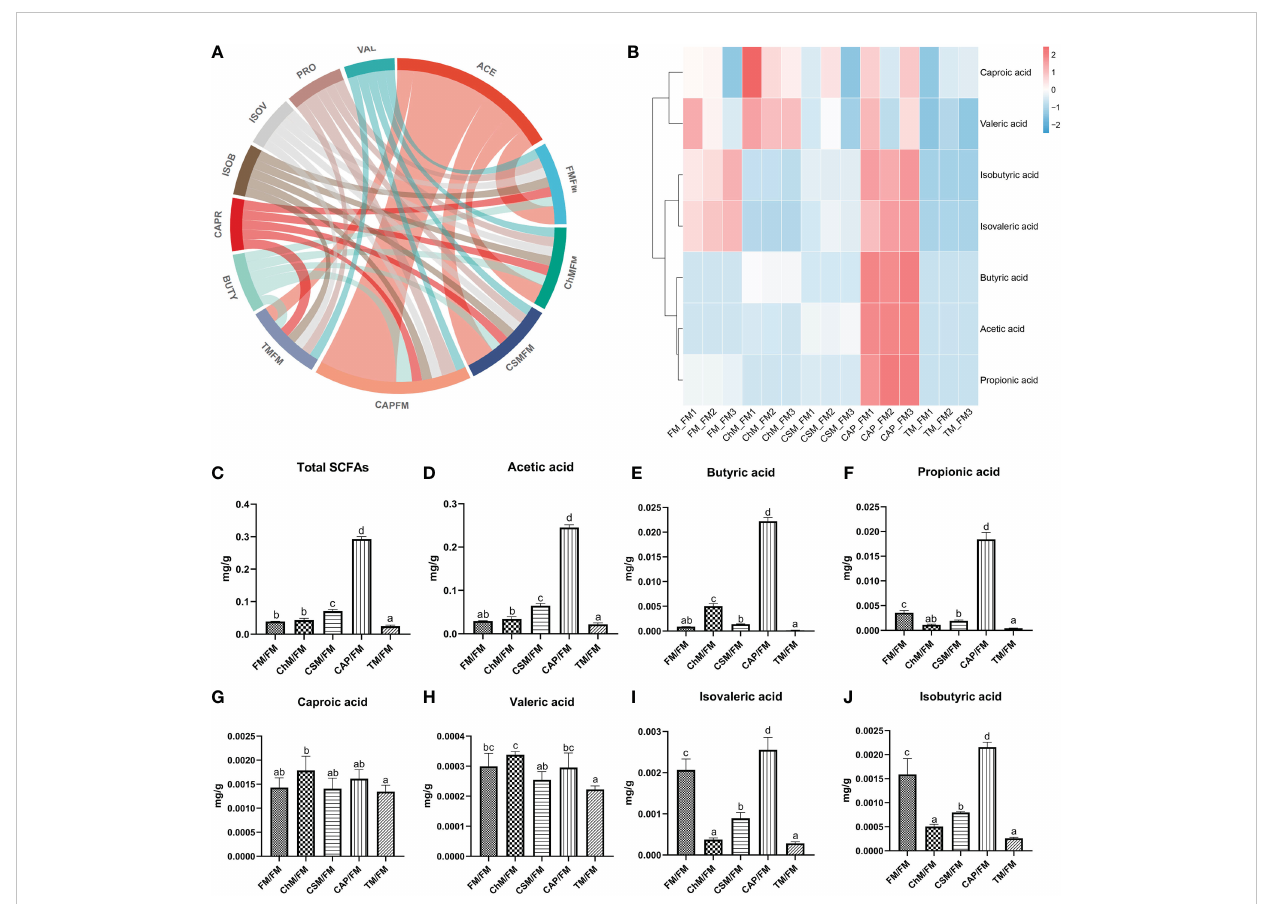
FIGURE 7 The intestinal metabolome of juvenile largemouth bass intestinal contents under an alternate feeding strategy were shown as follows: Distribution of SCFAs in each diet (A) , relative abundance of SCFAs in each diet (B) , total SCFAs contents (C) , acetic acid content (D) , butyric acid content (E) , propionic acid content (F) , caproic acid content (G) , valeric acid content (H) , isovaleric acid content (I) , and isobutyric acid content (J) . Data are expressed as mean (S.E.M). Values on each column with different superscripts typi fi ed statistical differences ( P<0.05